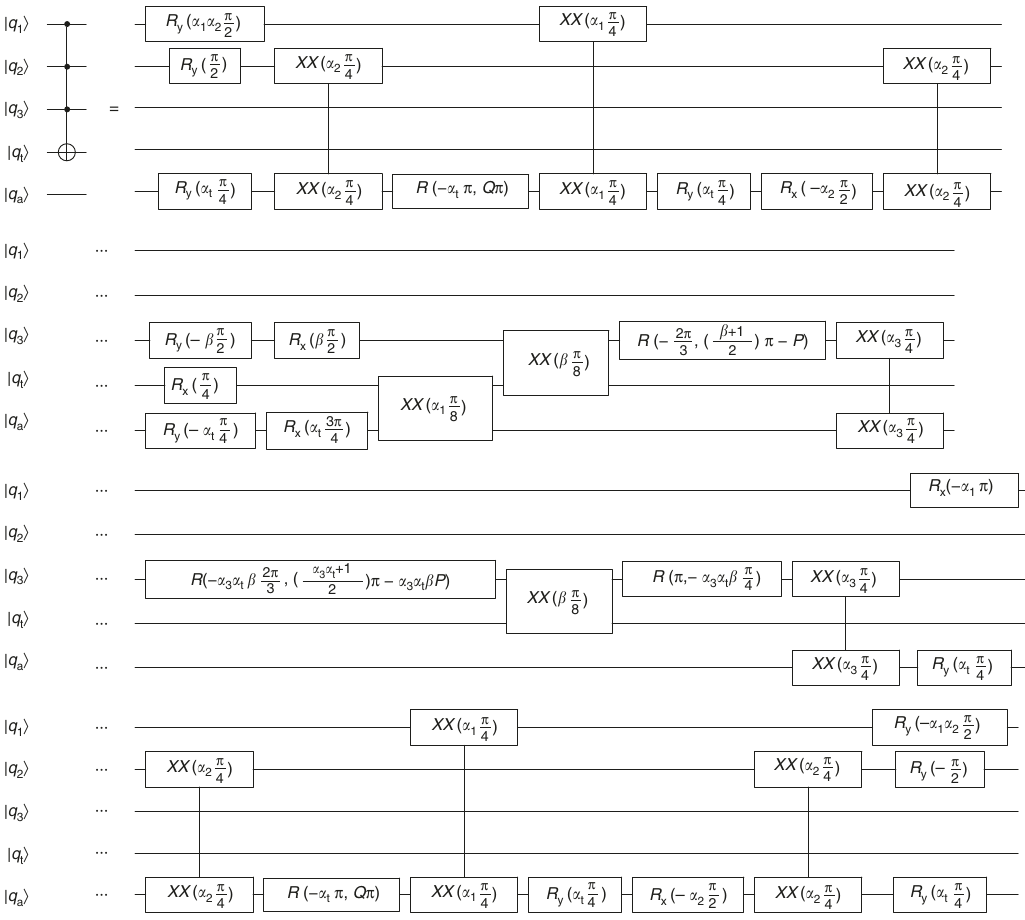
count for increasing search database size as a function of the number of qubits n , and for a constant number of solutions t . For a database of size N = 2 n stored on n qubits, the ampli fi cation stage requires one Toffoli- n gate, and the t -solution oracle stage requires at worst t Toffoli- n (for a phase oracle) or Toffoli-( n + 1) (for a Boolean oracle) gates; optimal oracles for particular sets of marked states may require even fewer two-qubit gates. The method used here to construct the Toffoli-4 circuit scales to Toffoli- n gates as 6 n − 13 in the (cid:9) in the ancilla count 29 . This two-qubit gate count and as n (cid:3) 3 2 paves the way for more extensive use of the Grover search algorithm in solving larger problems on quantum computers, including using the circuit as a subroutine for other quantum algorithms.